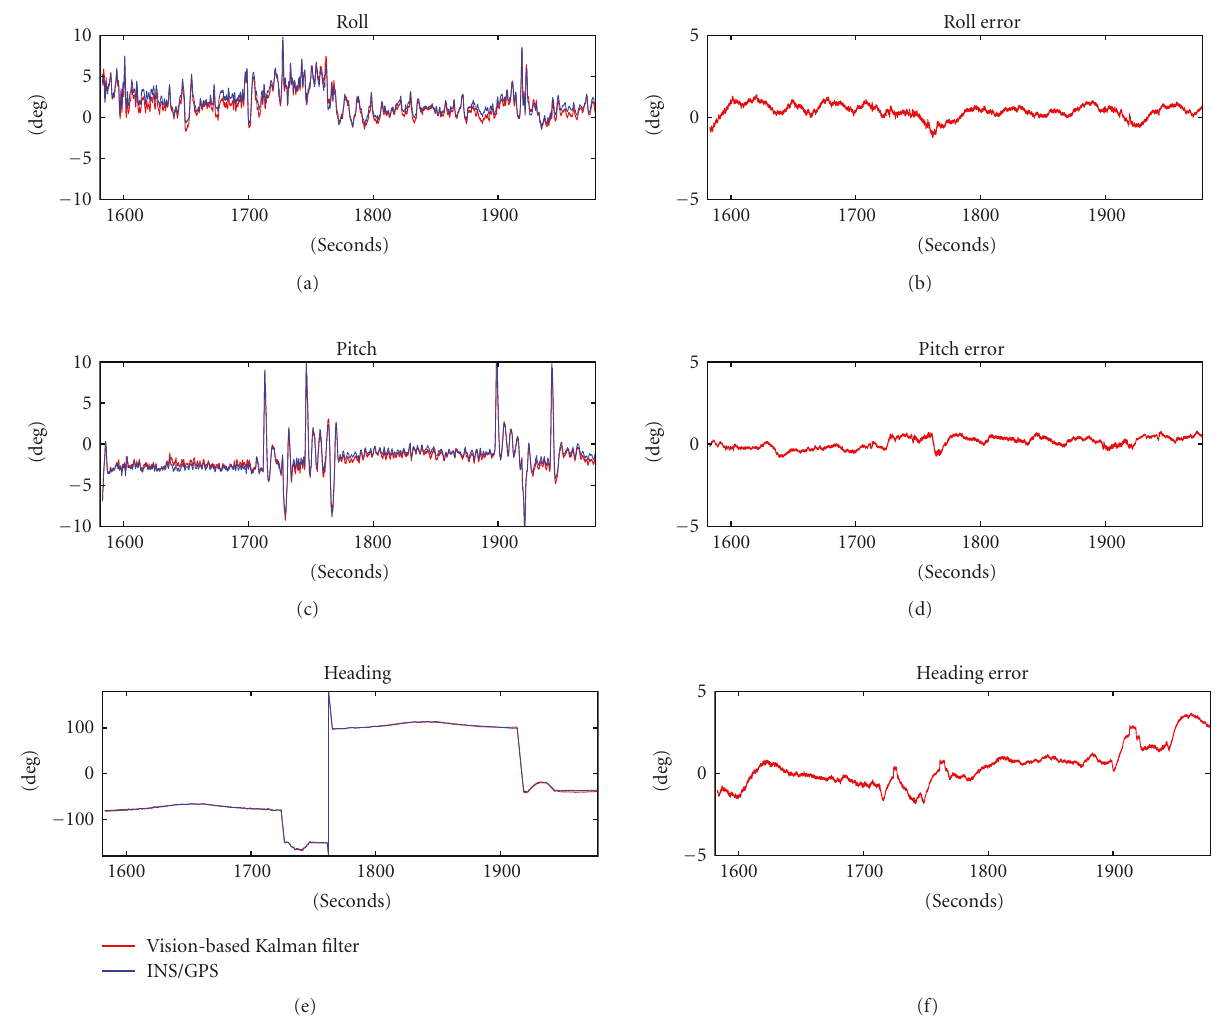
Figure 11: Estimated Kalman filter attitude angles with error